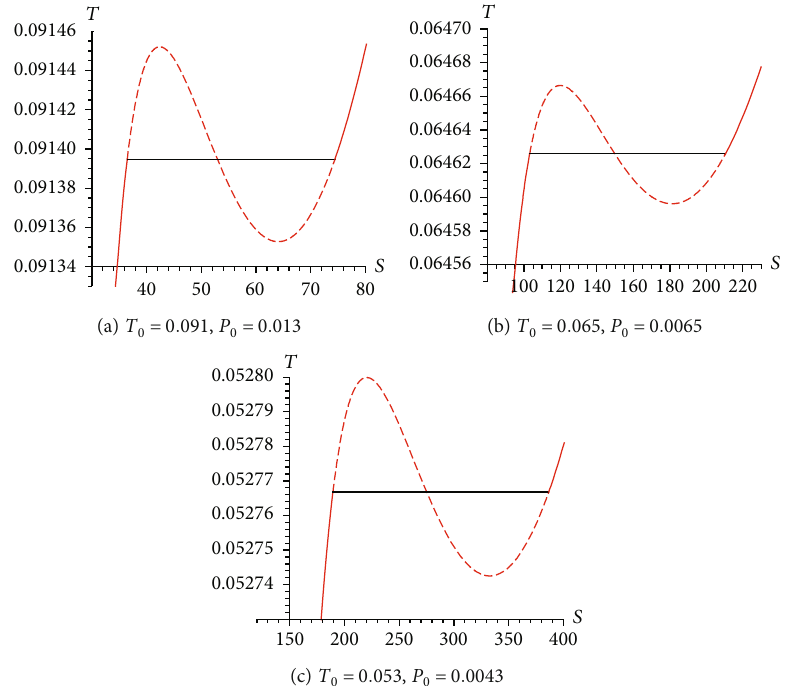
/ r = 0 : 7 . The parameters 1 2